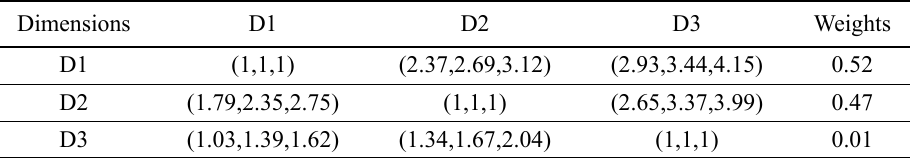
Table 2. Pair-wise comparison matrix and weights of assessment dimensions